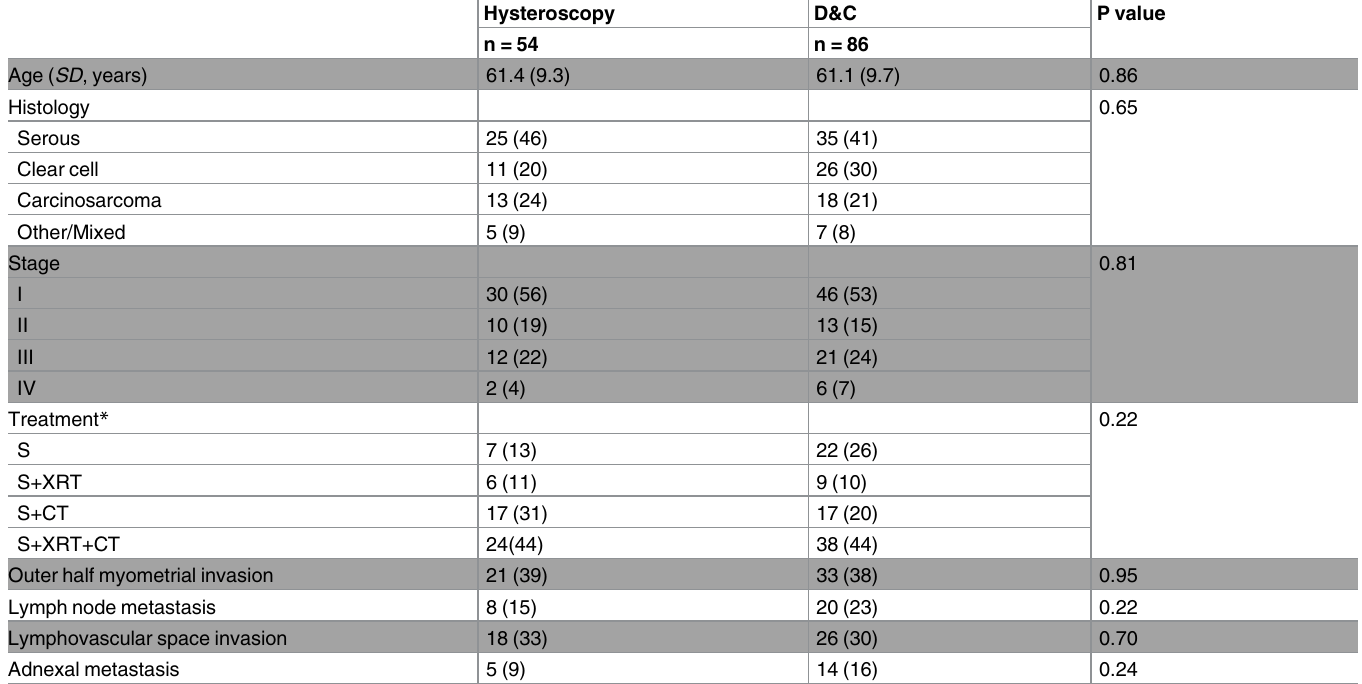
Table 1. Comparison of clinical and pathological characteristics.